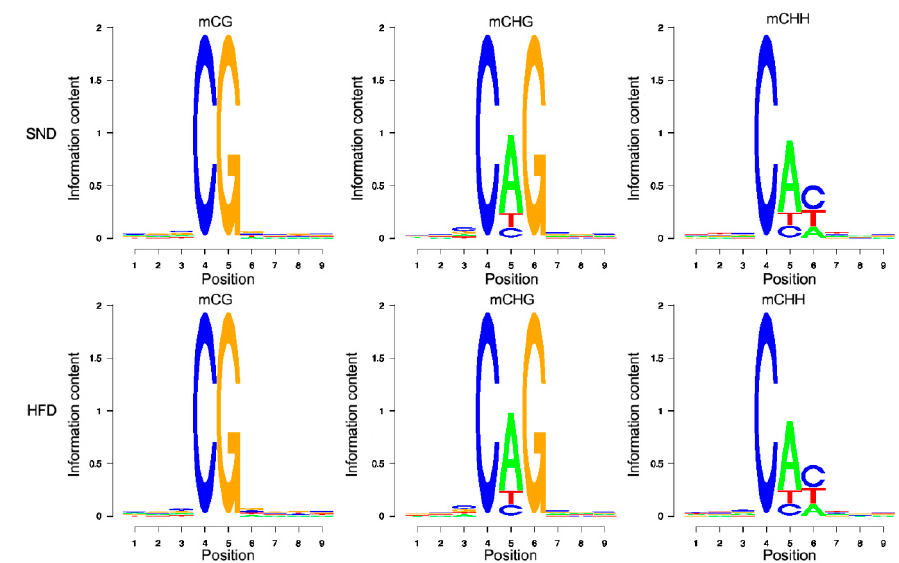
Figure 1. Genome-wide characteristics of methylated C bases. Sequence characteristics of bases near mCG, mCHG, and mCHH in the SND and HFD group.